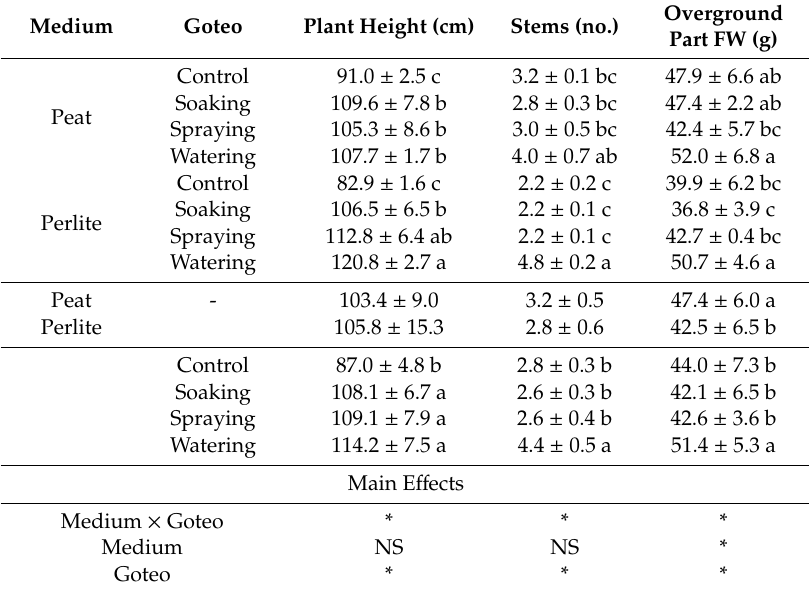
Table 2. E ff ect of medium and biostimulator Goteo on growth parameters of Pennisetum “Vertigo” plants after 2 months of pot cultivation.